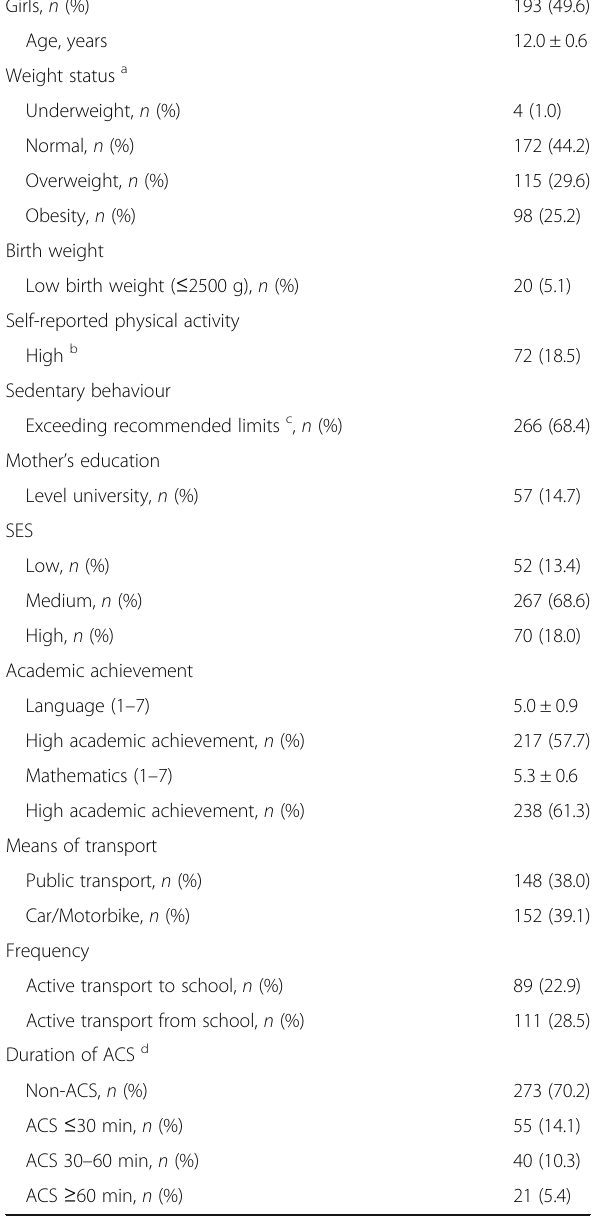
Table 1 Descriptive characteristics for the participants in this